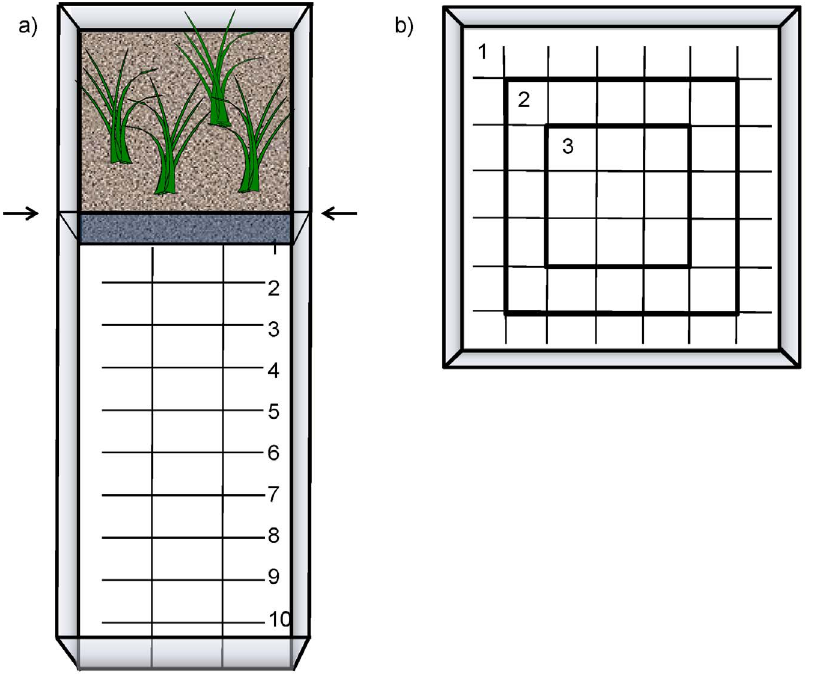
Figure 1. Experimental set-up from above for two boldness assays used on two-spotted goby males. a) Emergence test with sheltered area on top and sliding divider indicated with arrows, distance from divider marked 1–10 with 5 cm between lines, total area 25 6 75 cm. b) Open field test, showing the areas defined as zones 1–3, grids 6 6 6 cm, total area 45 6 45 cm (outermost edges, 1.5 cm, not marked). doi:10.1371/journal.pone.0093354.g001 PLOS ONE |